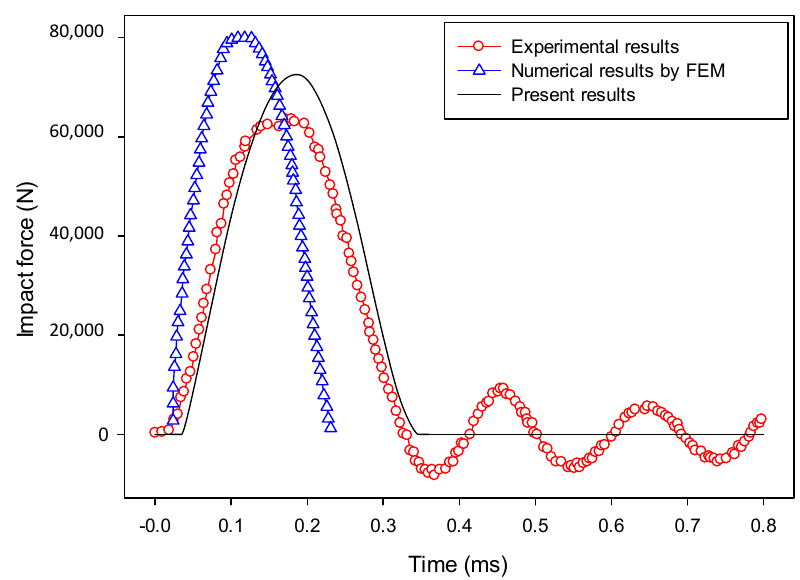
Figure 30. Impact force versus time (impact velocity = 1.76 m/s).